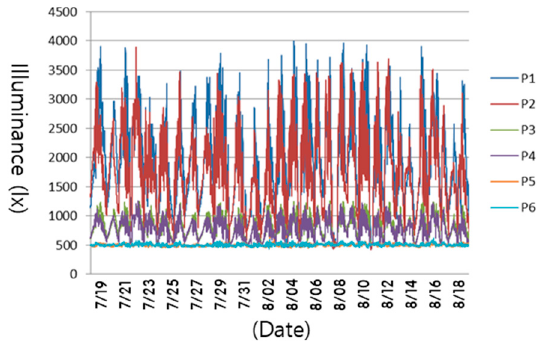
Figure 13. Daily measurement results for the final workplane illuminance.